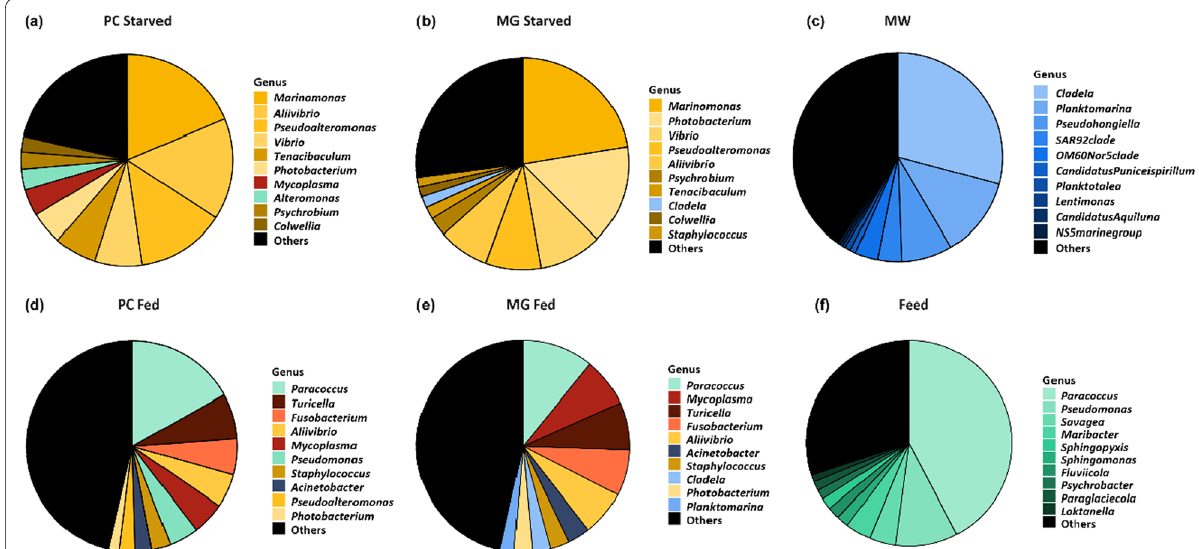
Fig. 4 Pie charts showing the mean relative abundance of the 10 most abundant taxa on genus level for pyloric caeca of starved fish ( a ), midgut of starved fish ( b ), marine water (MW ( c )), pyloric caeca of recently fed fish ( d ), midgut of recently fed fish ( e ) and fish feed ( f ). Starved fish were without food for at least 48 h. For illustration purposes samples of T0 and T1 were pooled